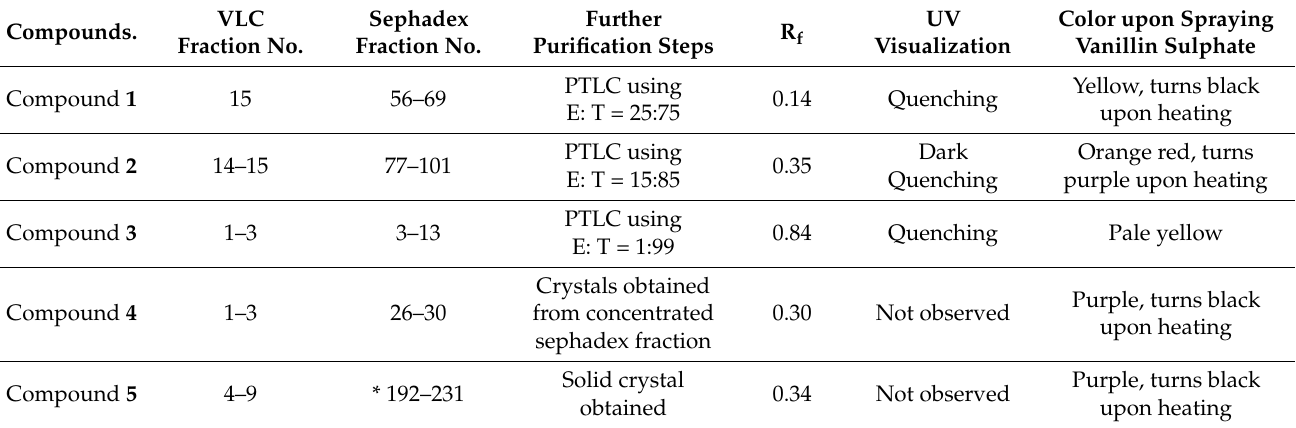
Table 2. Summary of the isolated compounds from the crude methanol extract of Glycosmis cyanocarpa .